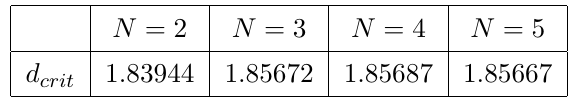
Figure 7 . Variation of the real part of the critical exponents with the spatial dimension d , for N = 2 . The figures show two different zooms.